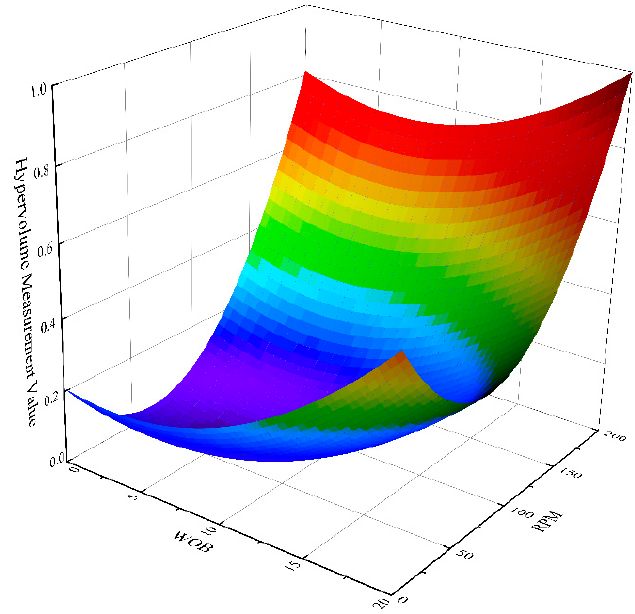
Figure 7. Objective function—favors medium WOB and medium RPM.